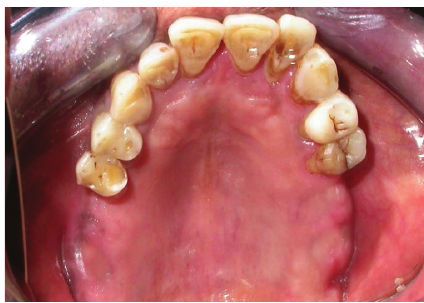
Figure 3: Joint PFM crown with attachment on the model.